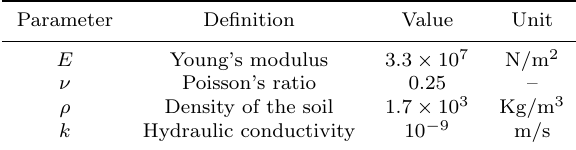
Table 2. Material parameters for the two-dimensional problem.